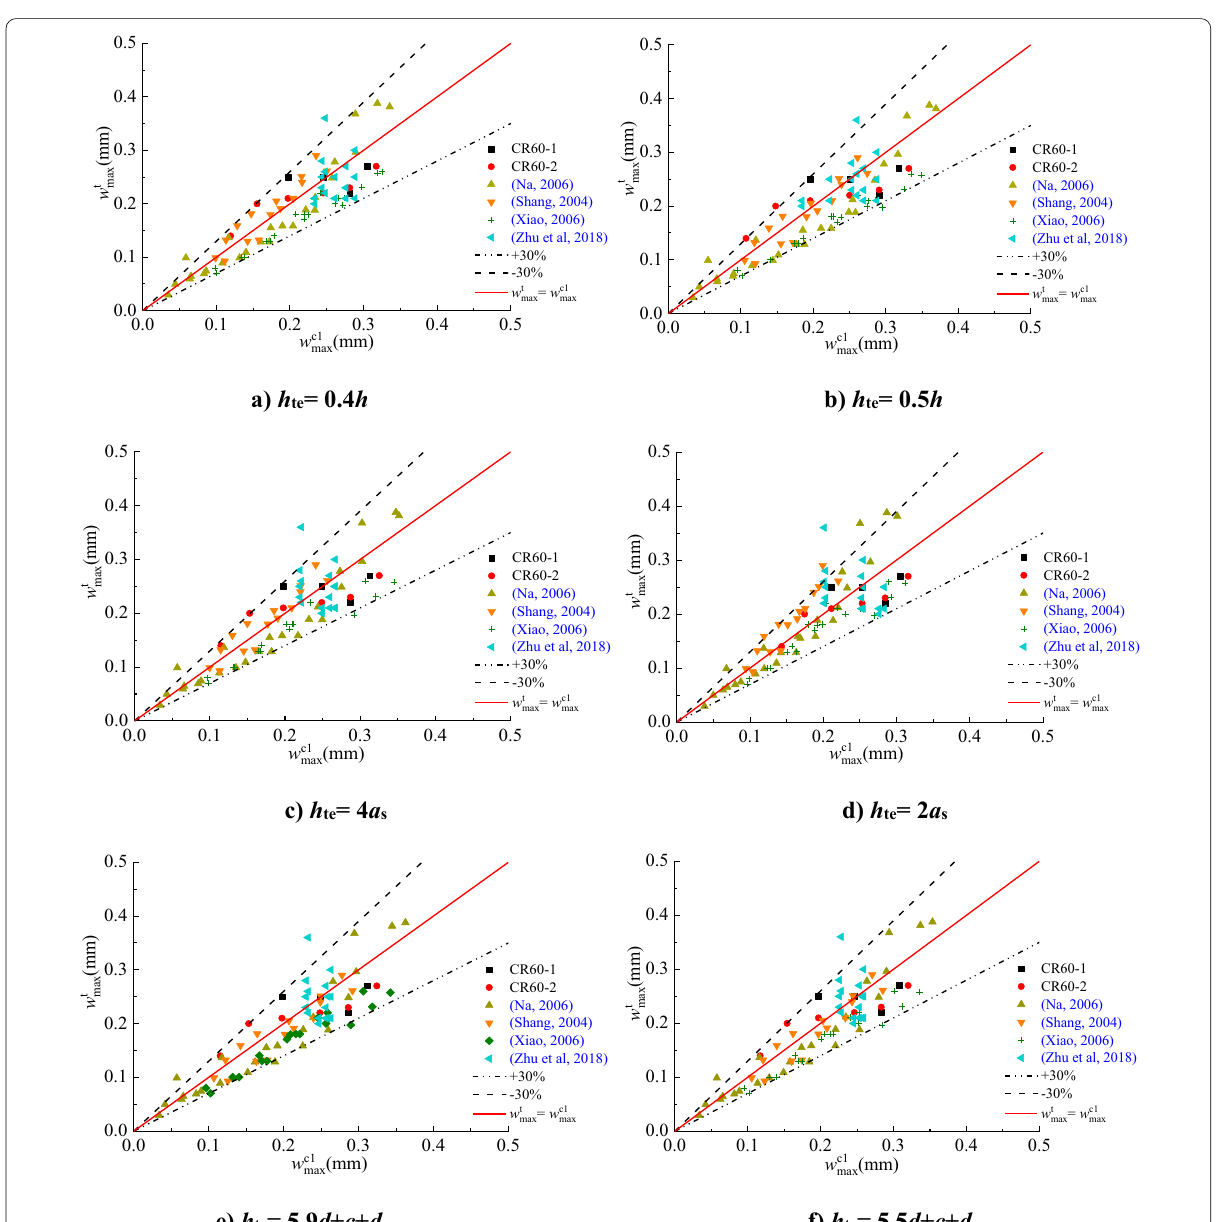
Fig. 16 Comparison of experimental w t max from RC beams with 400 MPa steel bars with calculated w c1 max by the proposed